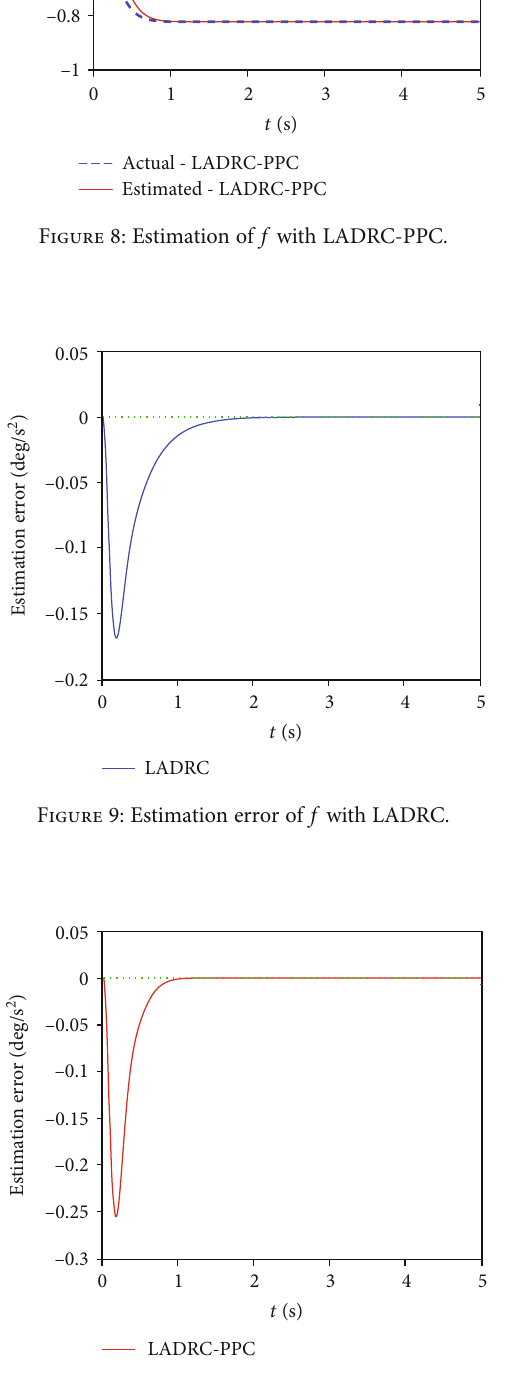
Figure 10: Estimation error of f with